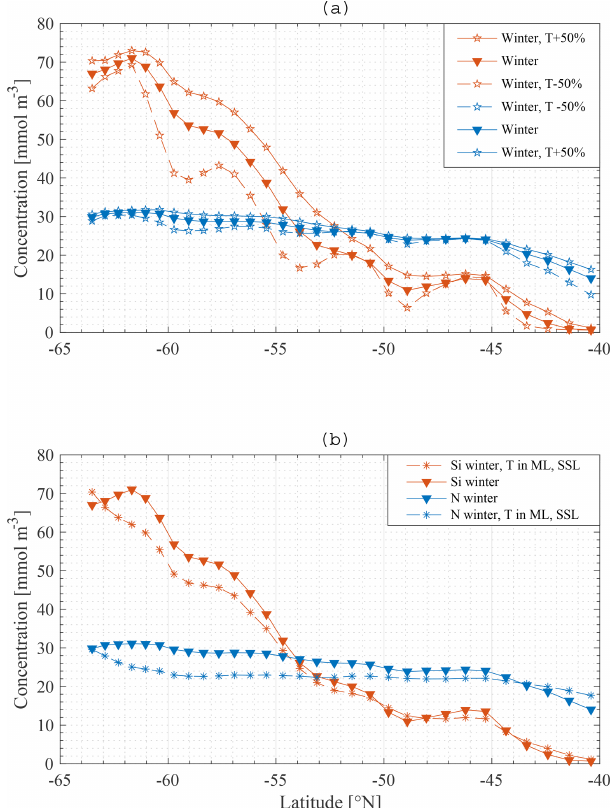
Figure 14. Model result: winter nitrate and silicate concentration in the mixed layer along the average meridional section – a compari- son of the standard model run ( (cid:72) ) with a model run where transport is increased and decreased with 50% ( ∗ ) (a) , and with a model run where transport is divided over the ML and SSL ( ∗ ) (b)